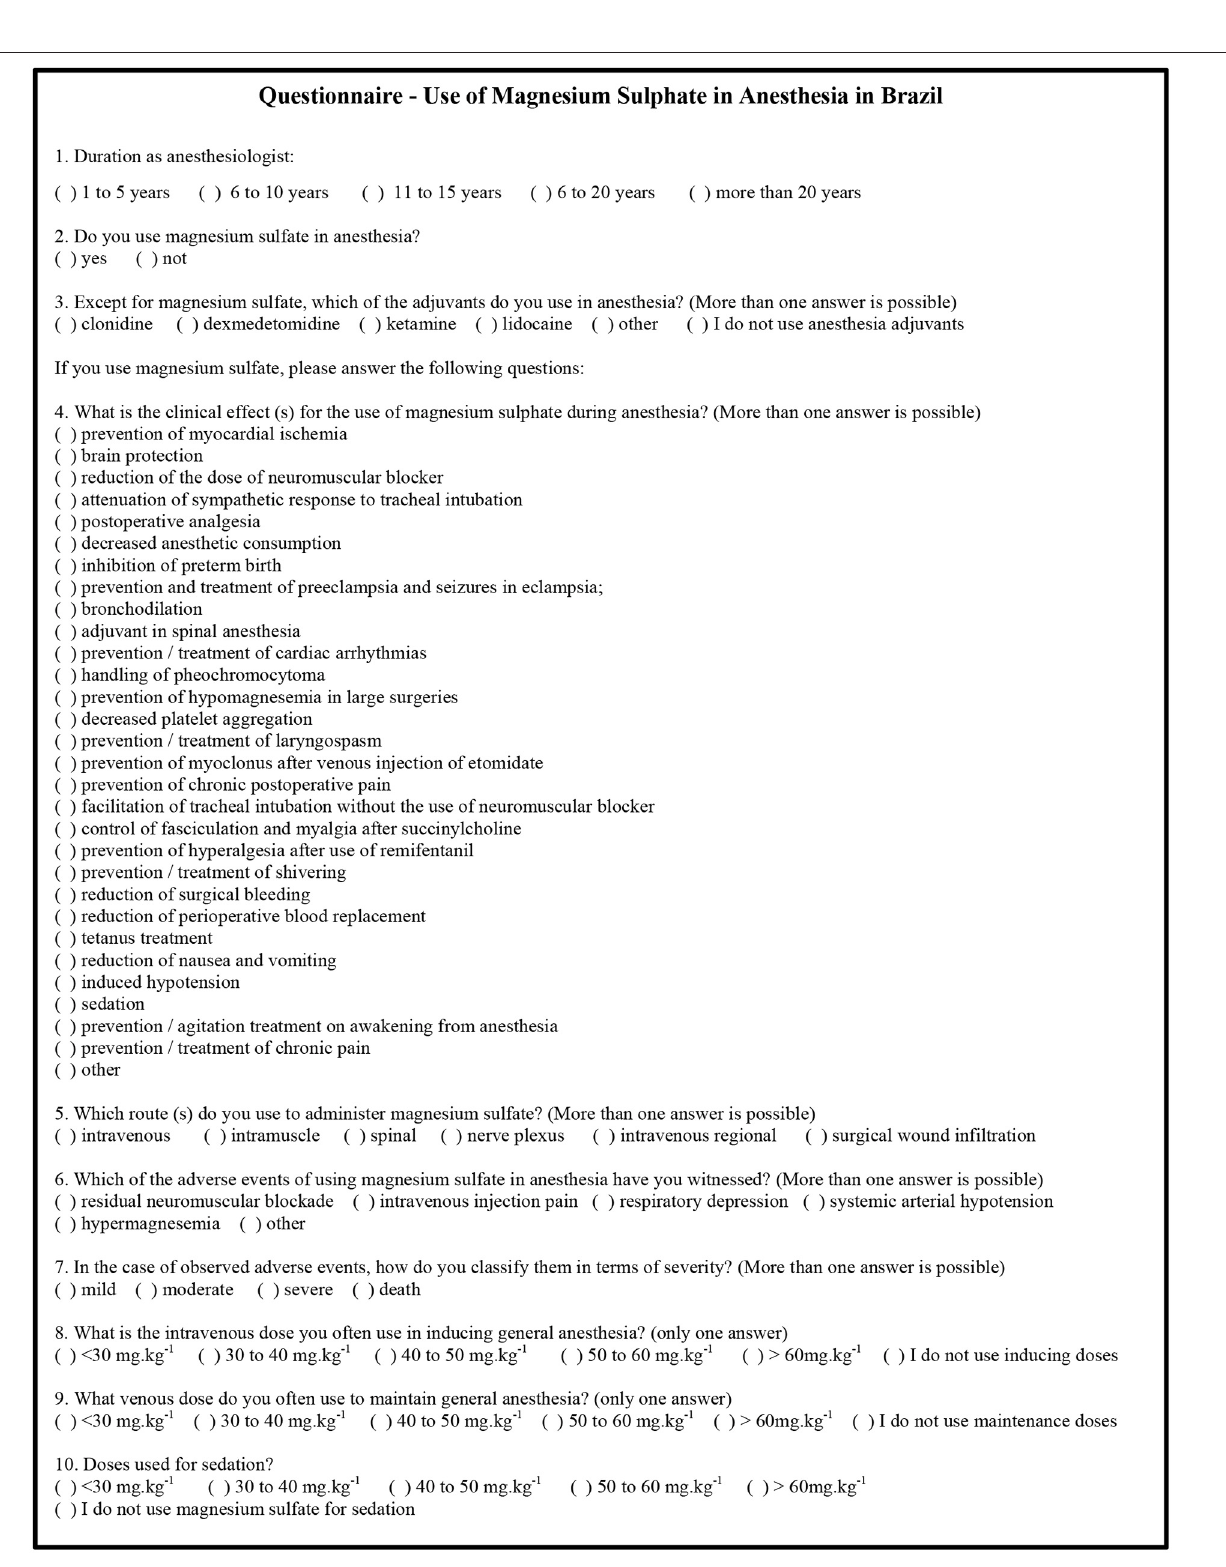
Frontiers in Pharmacology |